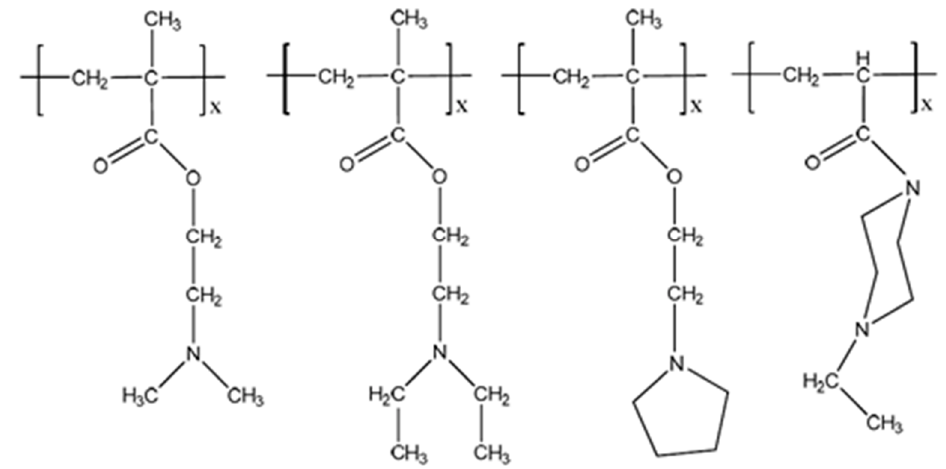
Figure 2. Swelling of hydrogel in acidic solution due to the formation of fixed charges on the polymer network.